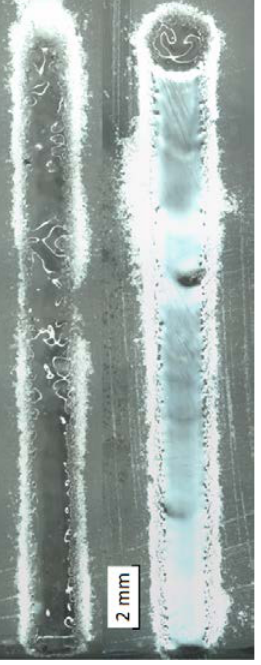
Fig. 7. Top view of the tracks made at scanning speed = 1 mm/s and power = 20 W (left) and 30 W (right), preheat temperature 1100K, layer thickness 200 microns.